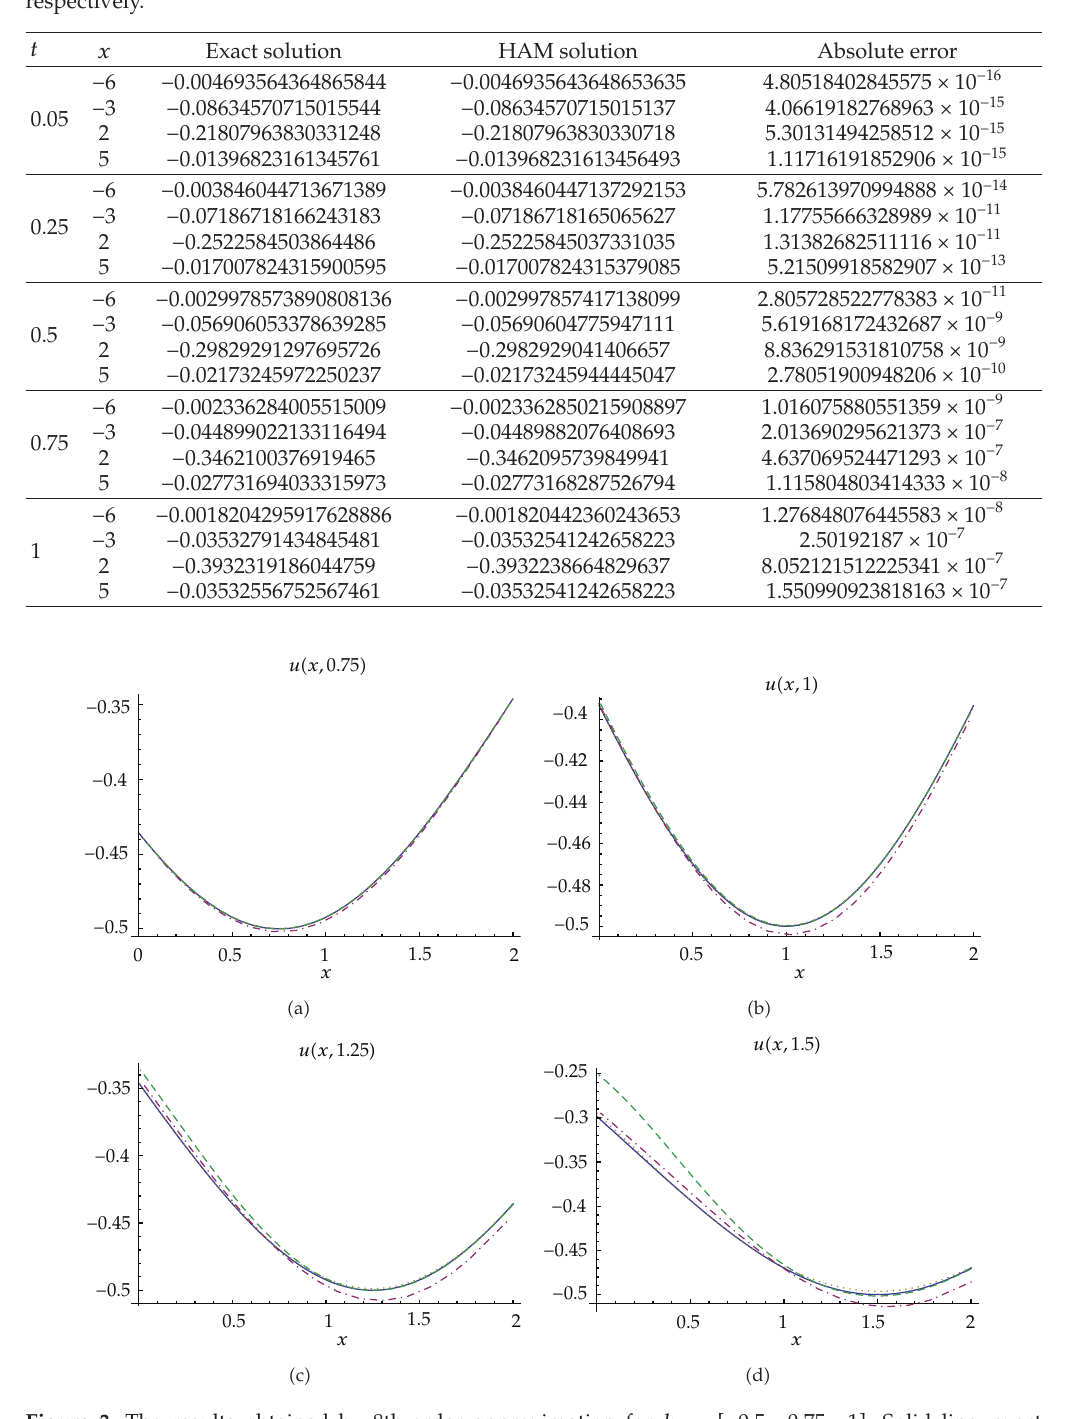
Figure 3: The results obtained by 8th-order approximation for h (cid:8) (cid:5) − 0 . 5; − 0 . 75; − 1 (cid:6) . Solid line: exact solution; dashing-large for h (cid:8) − 0 . 5; dashing-medium for h (cid:8) − 0 . 75; dashing-tiny for h (cid:8) −